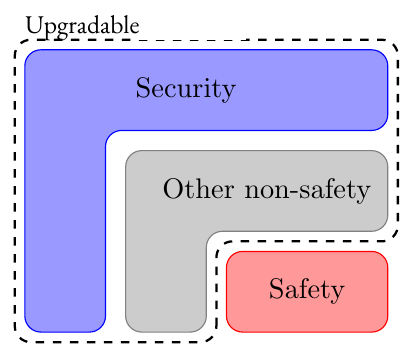
Figure 8. Upgradable type of software